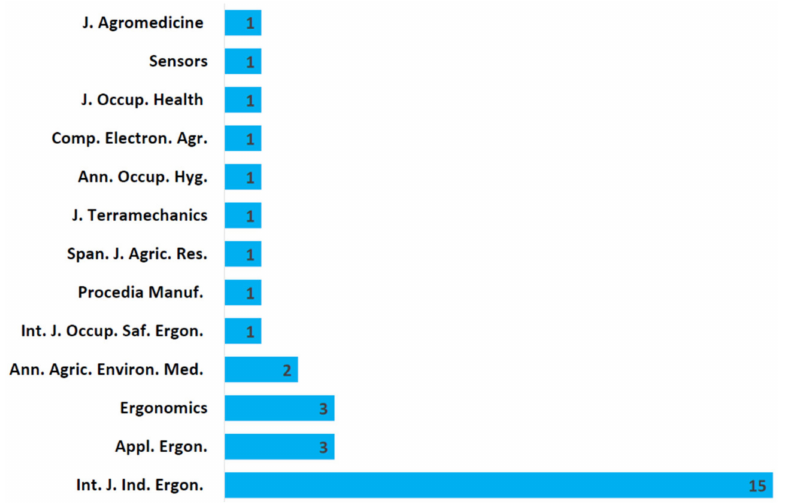
Figure 4. Distribution of all contributing international